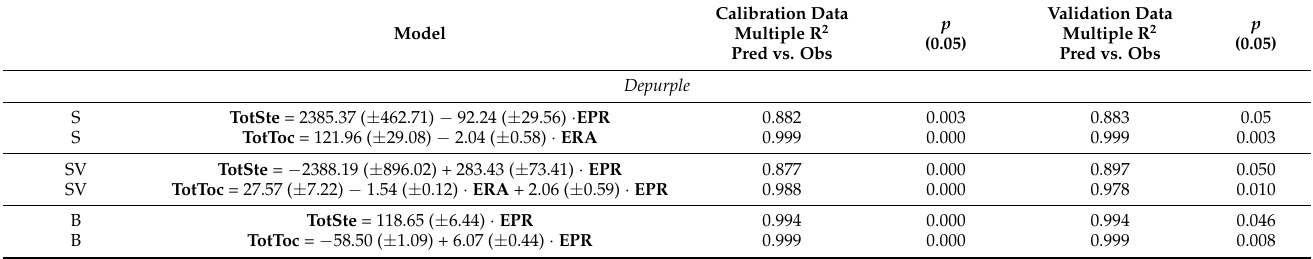
Table 4. Application of stepwise regression analysis for the prediction of the concentration of sterols and tocopherols (on dry basis) that can be extracted from cauliflower after cooking by using ERA and EPR as input